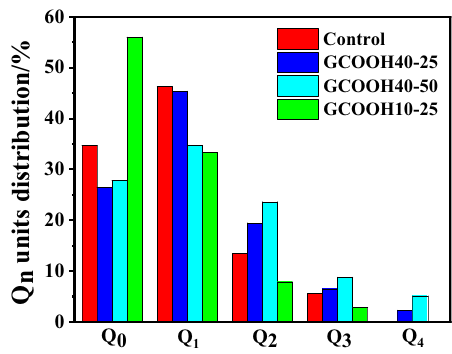
Figure 6: Distribution of Q n content in each